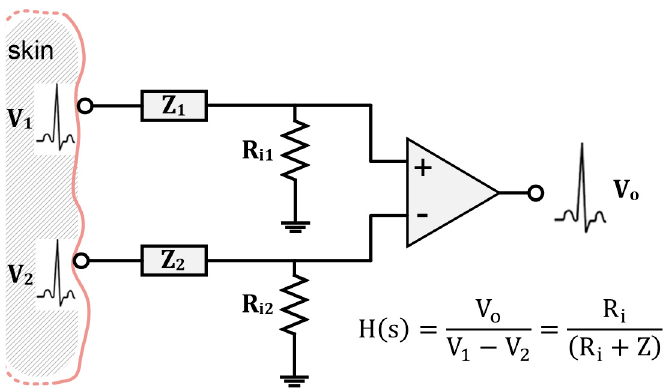
Figure 2. Schematic representation of the path of biopotential signals starting from the skin surface until acquisition and display at the circuit output [adapted from 88].